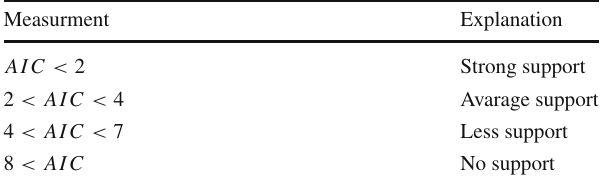
Table 2 The level of support for each model from AIC